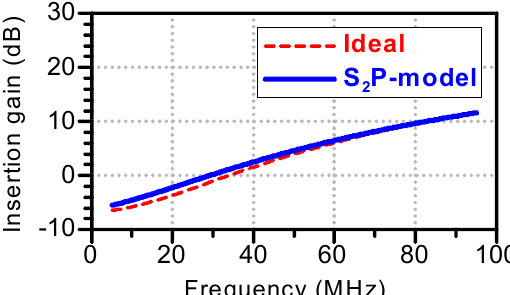
Figure 4: Comparison of the group delay frequency responses from the ideal RF circuit and realistic circuit with S2P models including the bias